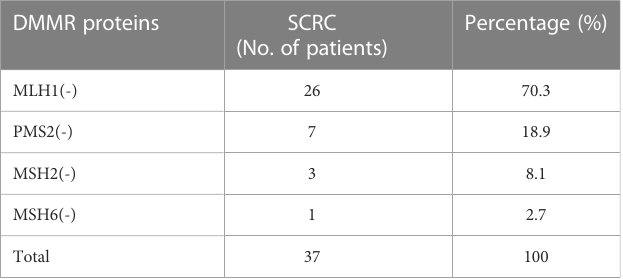
TABLE 1 Amount of the patterns in 37 SCRC patients with